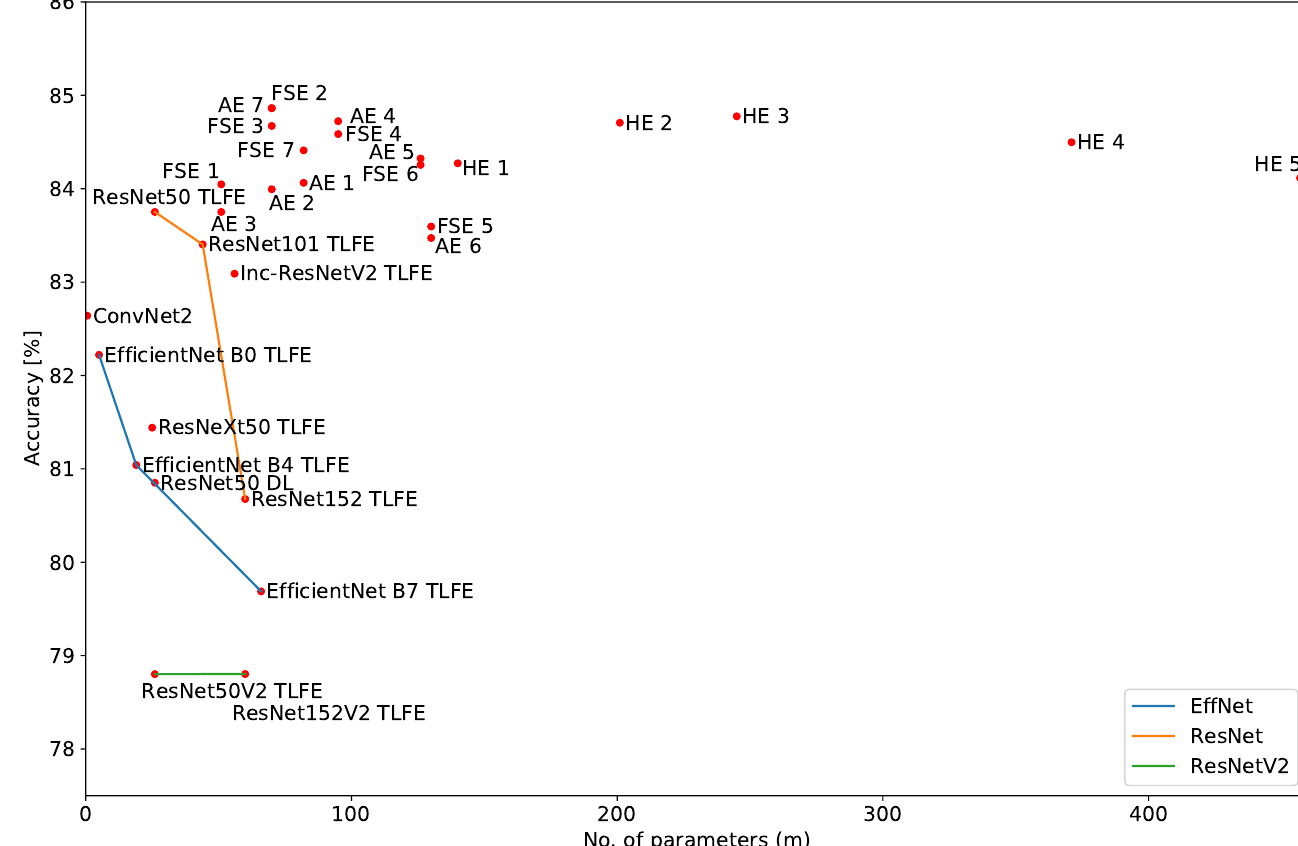
Figure 23. Model performance with reference to parameter size, zoomed in to show models with performances above 78%, FeatSpaceEnsNet, AvgEnsNet, and HybridEnsNet are abbreviated as FSE, AE, and HE, respectively. Mean accuracy of above 78% was achieved by all models with at least 30 m